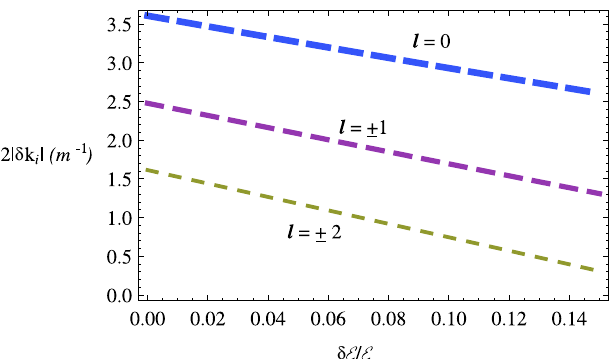
FIG. 1. (Color) Differential power for individual OAM modes on a Gaussian e-beam profile, with 11 radial modes included in (cid:3) 0 : 7 m (cid:7) 1 , (cid:5) (cid:3) the expansion. FEL model parameters are: (cid:5) p (cid:3) 500 Amps peak current, (cid:3) (cid:3) 0 , (cid:2) (cid:3) 300 , K (cid:3) 1 : 8 , I p 425 nm